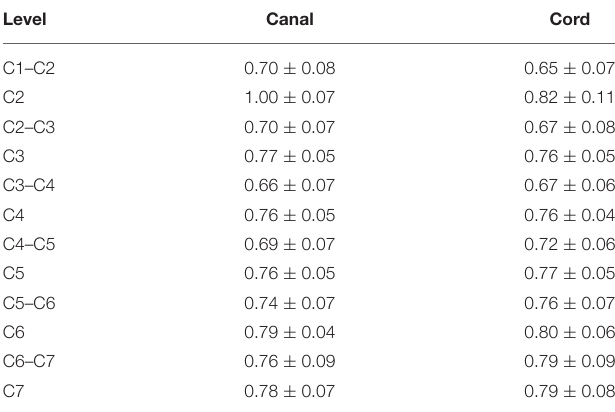
TABLE 4 | Height-to-width ratio of the spinal canal and cord (roundness